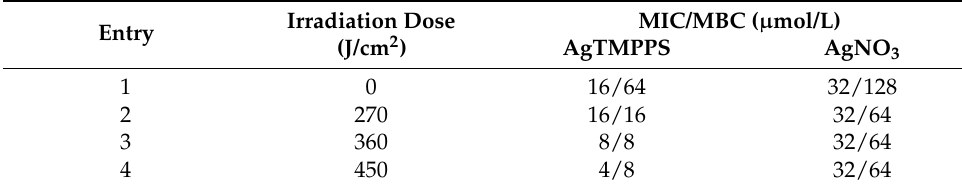
Table 2. MIC/MBC values of MRSA pathogens incubated with AgTMPPS and AgNO 3 under different laser irradiation doses *. MIC/MBC ( µ mol/L) Irradiation Dose Entry AgTMPPS AgNO 3 (J/cm 2 ) 0 16/64 32/128